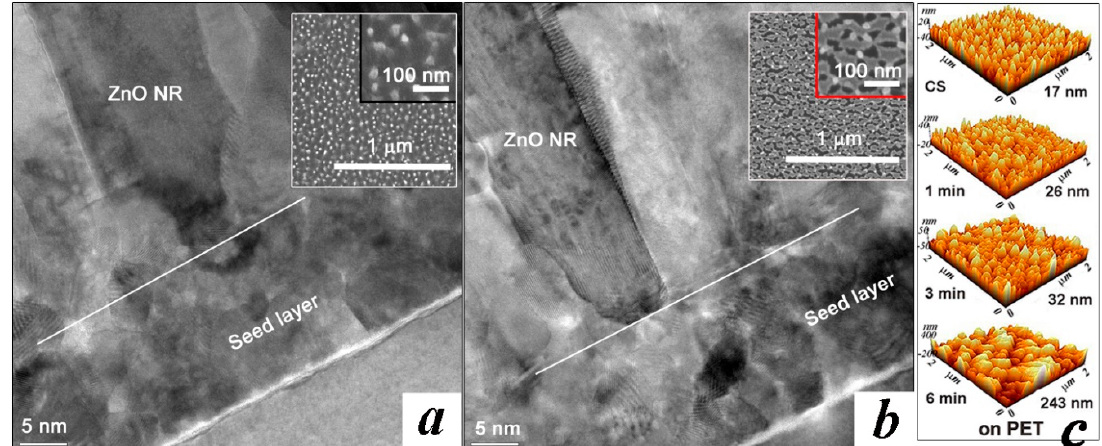
Figure 3. High-resolution cross-sectional TEM views of the ZnO NRs grown on the GaN substrates with ( a ) untreated SLs (CS) and ( b ) the SLs N 2 O plasma-treated for 6 min. Planar SEM views of the SLs prepared at each condition are shown in the top-right insets. ( c ) AFM surface morphologies of the untreated (CS) and N 2 O plasma treated SLs for 1, 3, and 6 min grown on PET substrates.